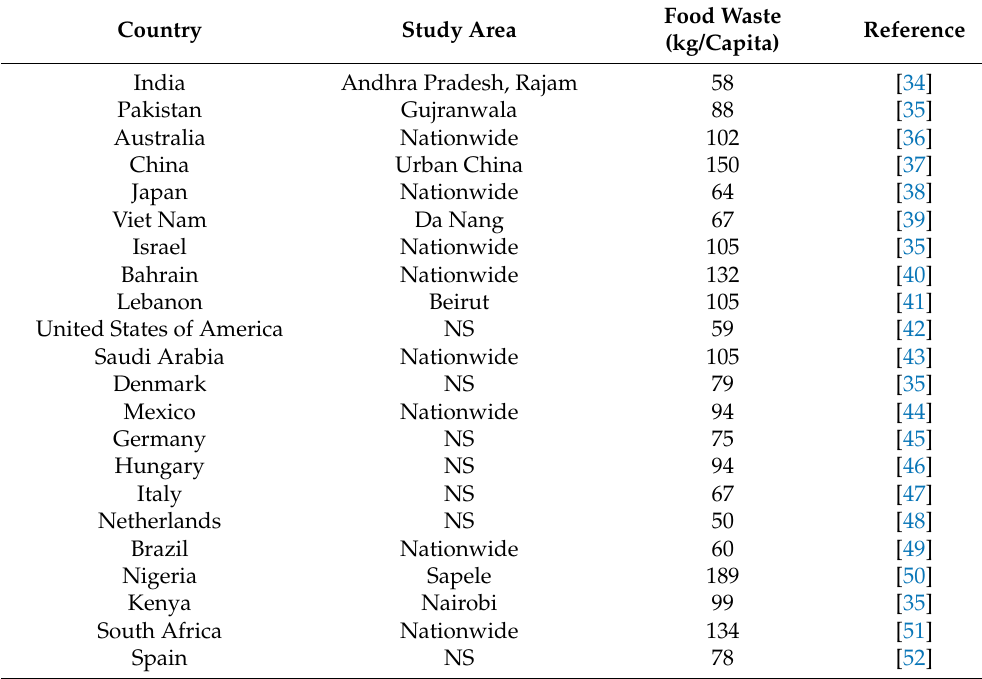
Table 1. Country and households’ food